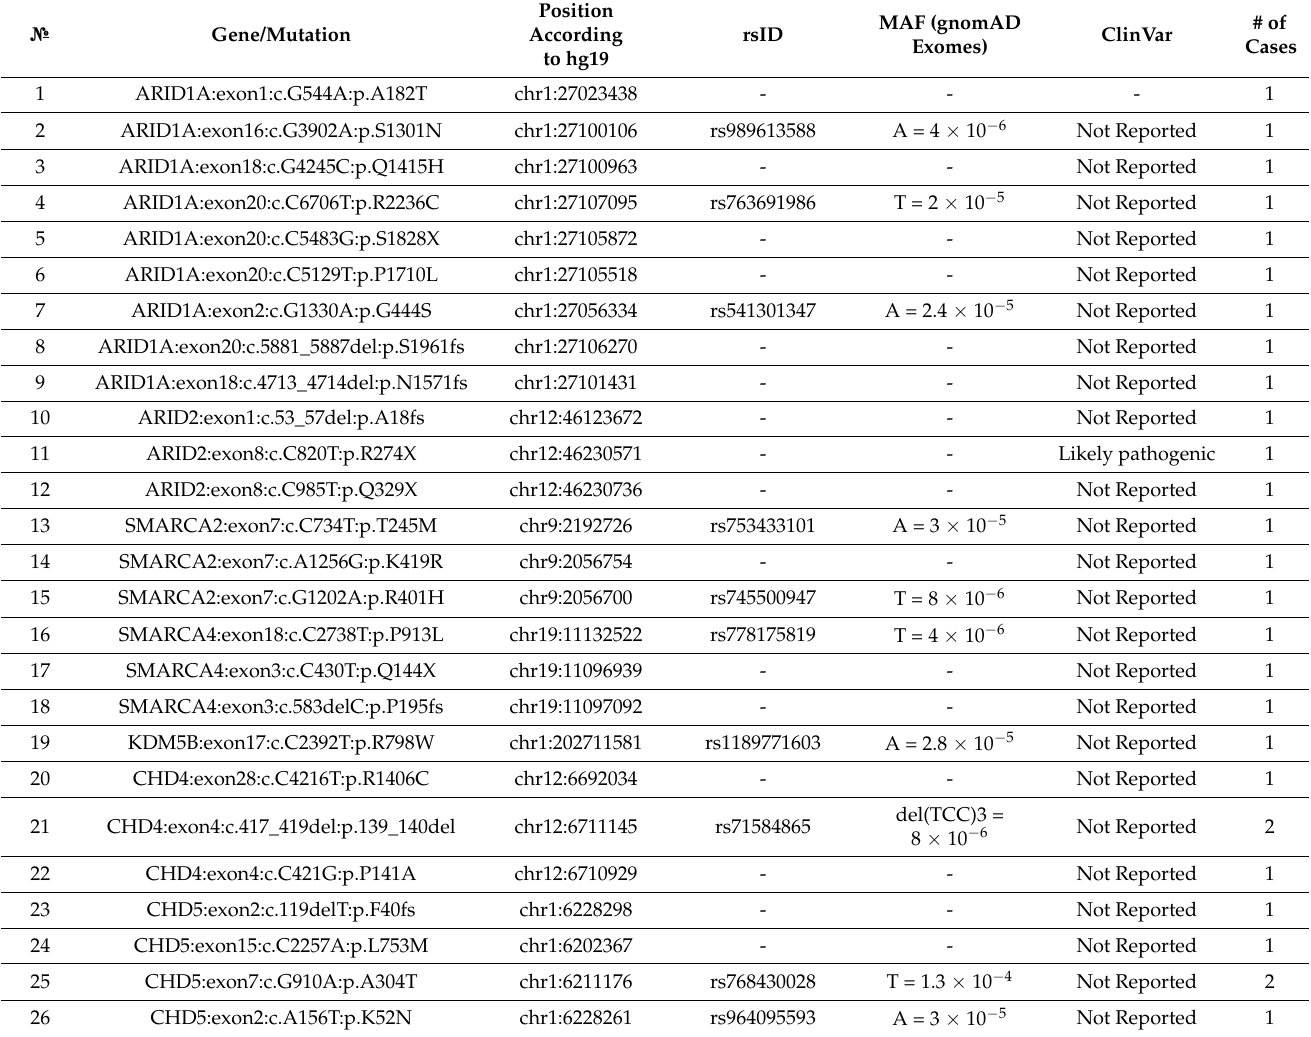
Table 1. Somatic mutations detected in epigenetic regulation genes in 135 gastric